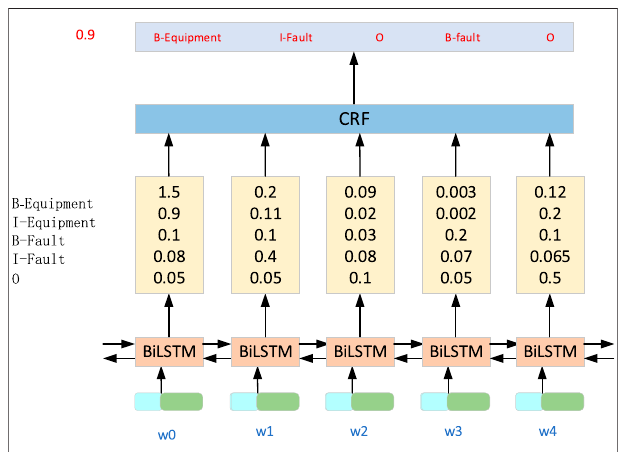
FIGURE 3 | BiLSTM-RCF Chinese entity recognition algorithm fl ow.